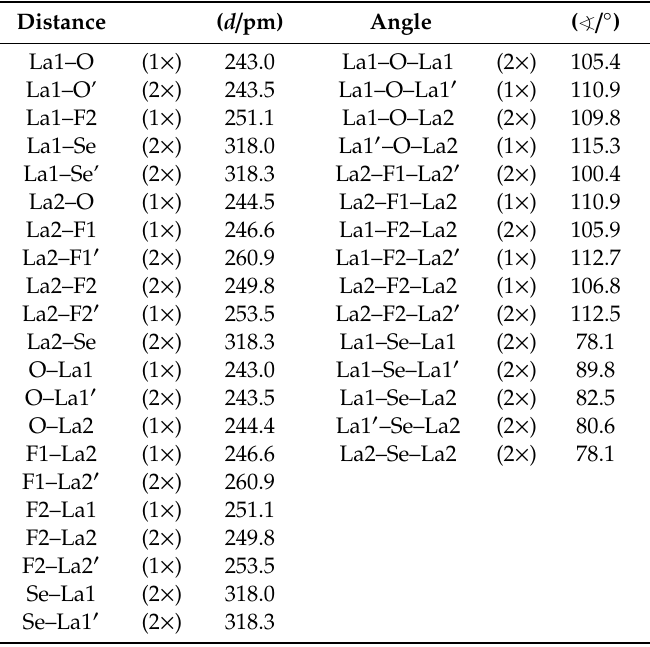
Table 5. Selected interatomic distances ( d / pm) and angles ( / ◦ ) in the crystal structure of B-type La 2 OF 2 Se.